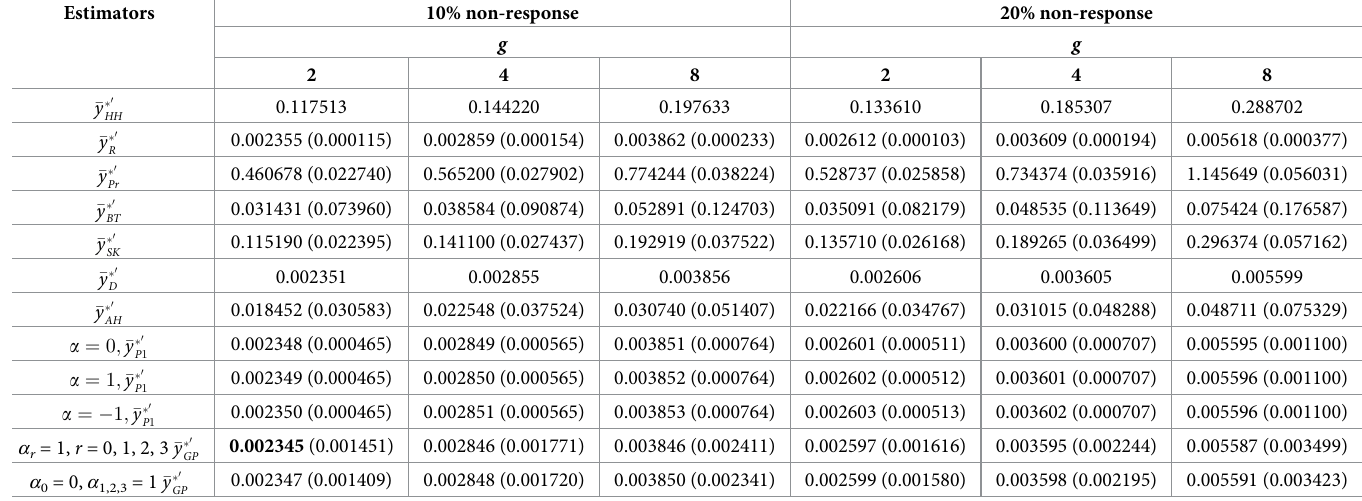
Table 3. Mean squared error and | Bias | (in brackets) values for different estimators for Population I without measurement error.